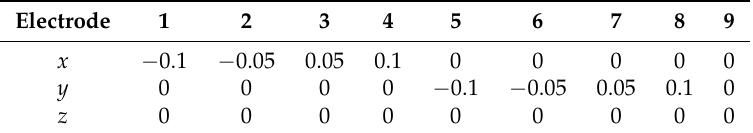
Table 2. Position of receiving electrodes for cross-shaped electrode configuration (unit: